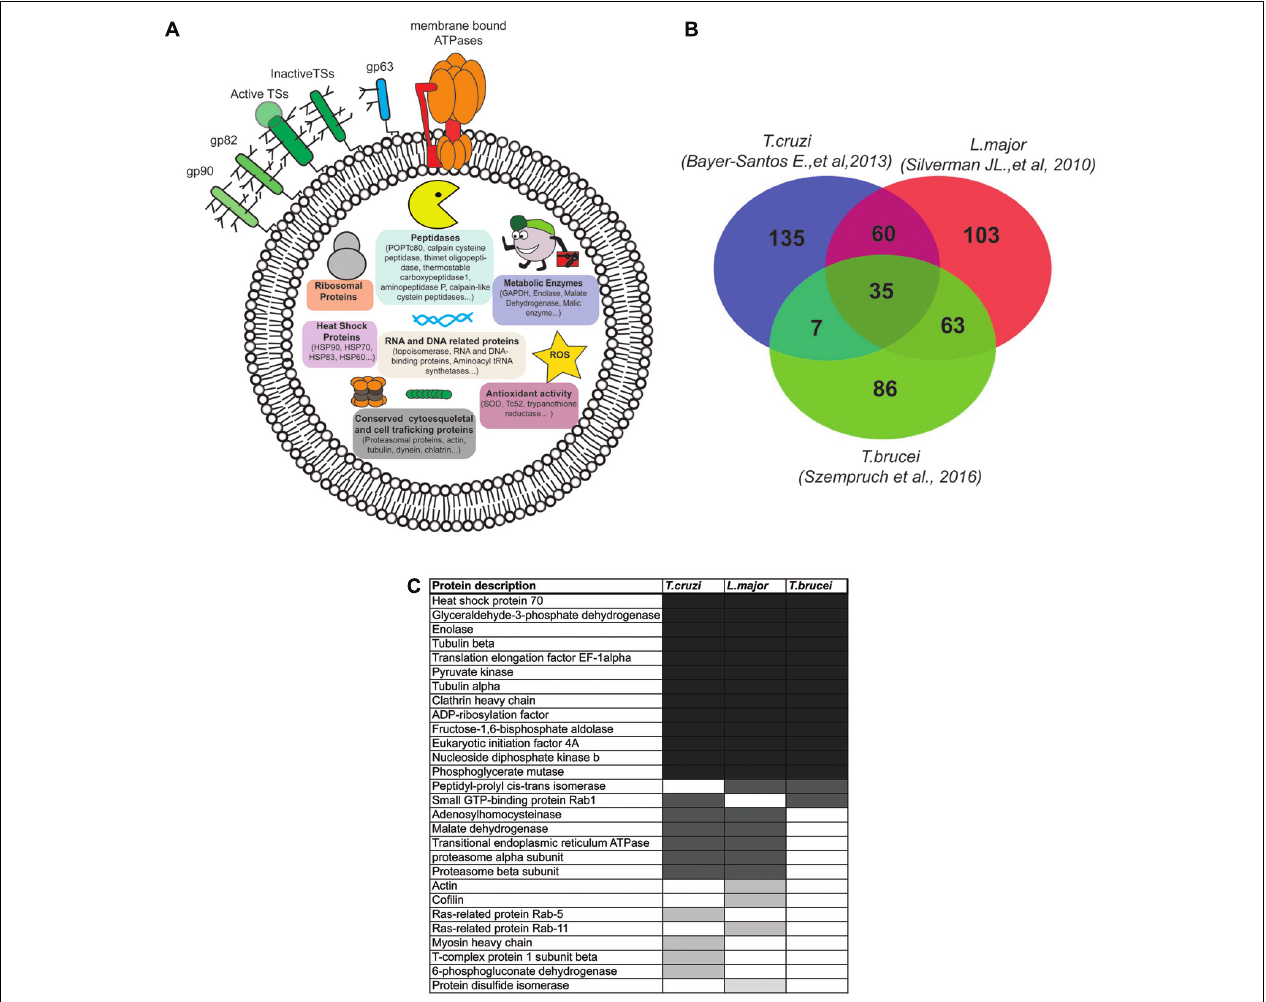
FIGURE 3 | Trypanosoma cruzi EV protein composition. (A) Schematic representation of protein components described in T. cruzi EVs. Note that for the purpose of the figure, the different components were not represented in the scale or density of molecules. Only representative proteins from each protein group (surface, peptidases, metabolic enzymes, conserved cytosqueletal, antioxidant, RNA and DNA related proteins) are represented. (B) Venn diagram of T. cruzi ( n = 237) (Bayer-Santos et al., 2013), Leishmania major ( n = 261) (Silverman et al., 2010), and Trypanosoma brucei ( n = 191) (Szempruch et al., 2016) EVs proteomic datasets (hypothetical proteins has been excluded from the analysis). (C) List of T. cruzi , L. major, and T. brucei EV proteins also found among the top 100 most frequently found vesicular proteins in mammalian EVs (Choi et al.,